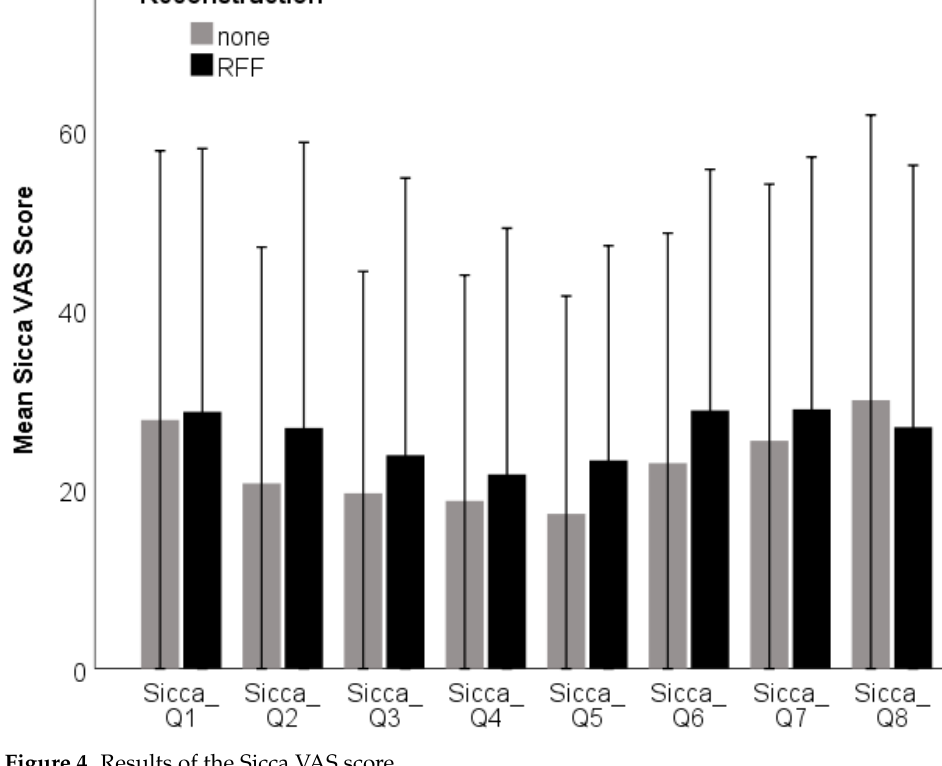
Figure 4. Results of the Sicca VAS score.